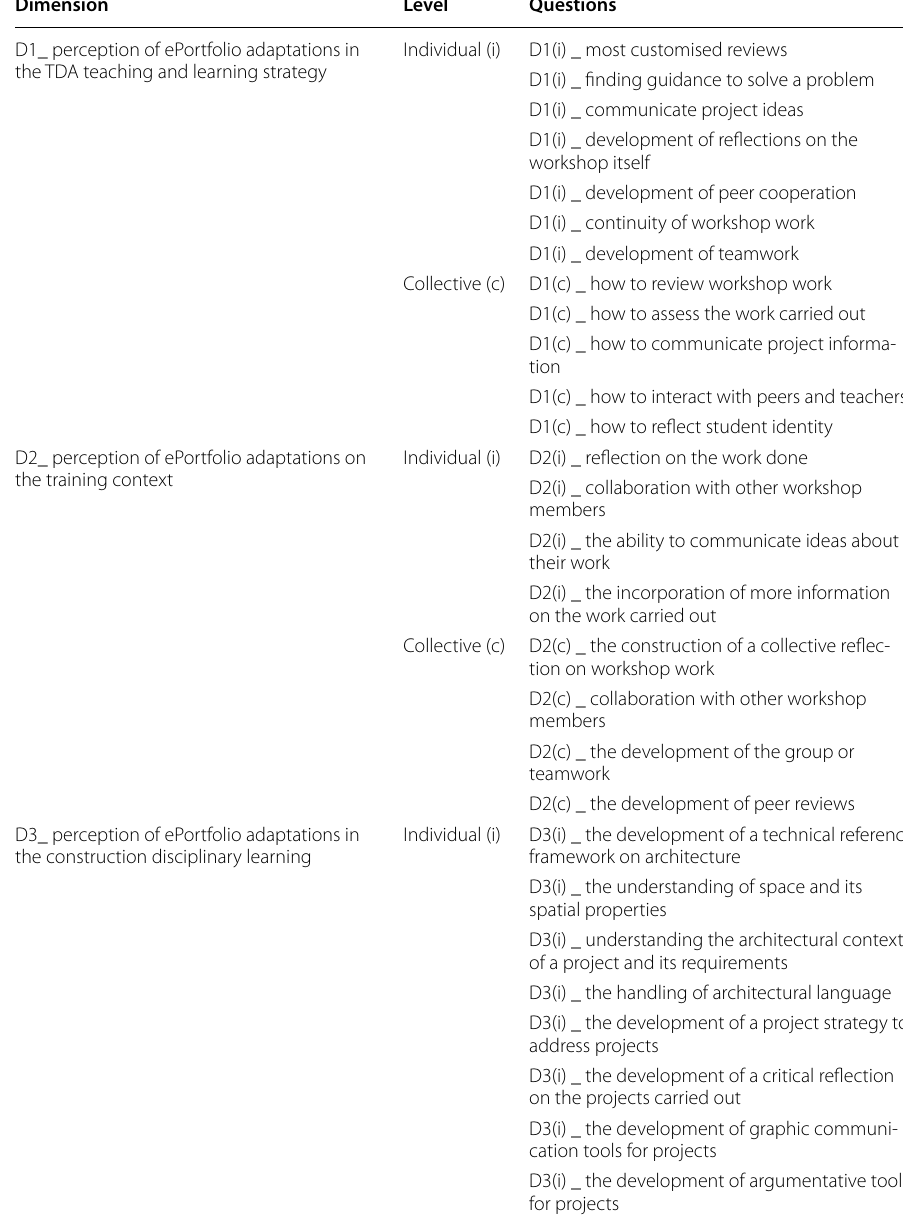
Table 1 The query structure with questions distributed on different dimensions and levels.